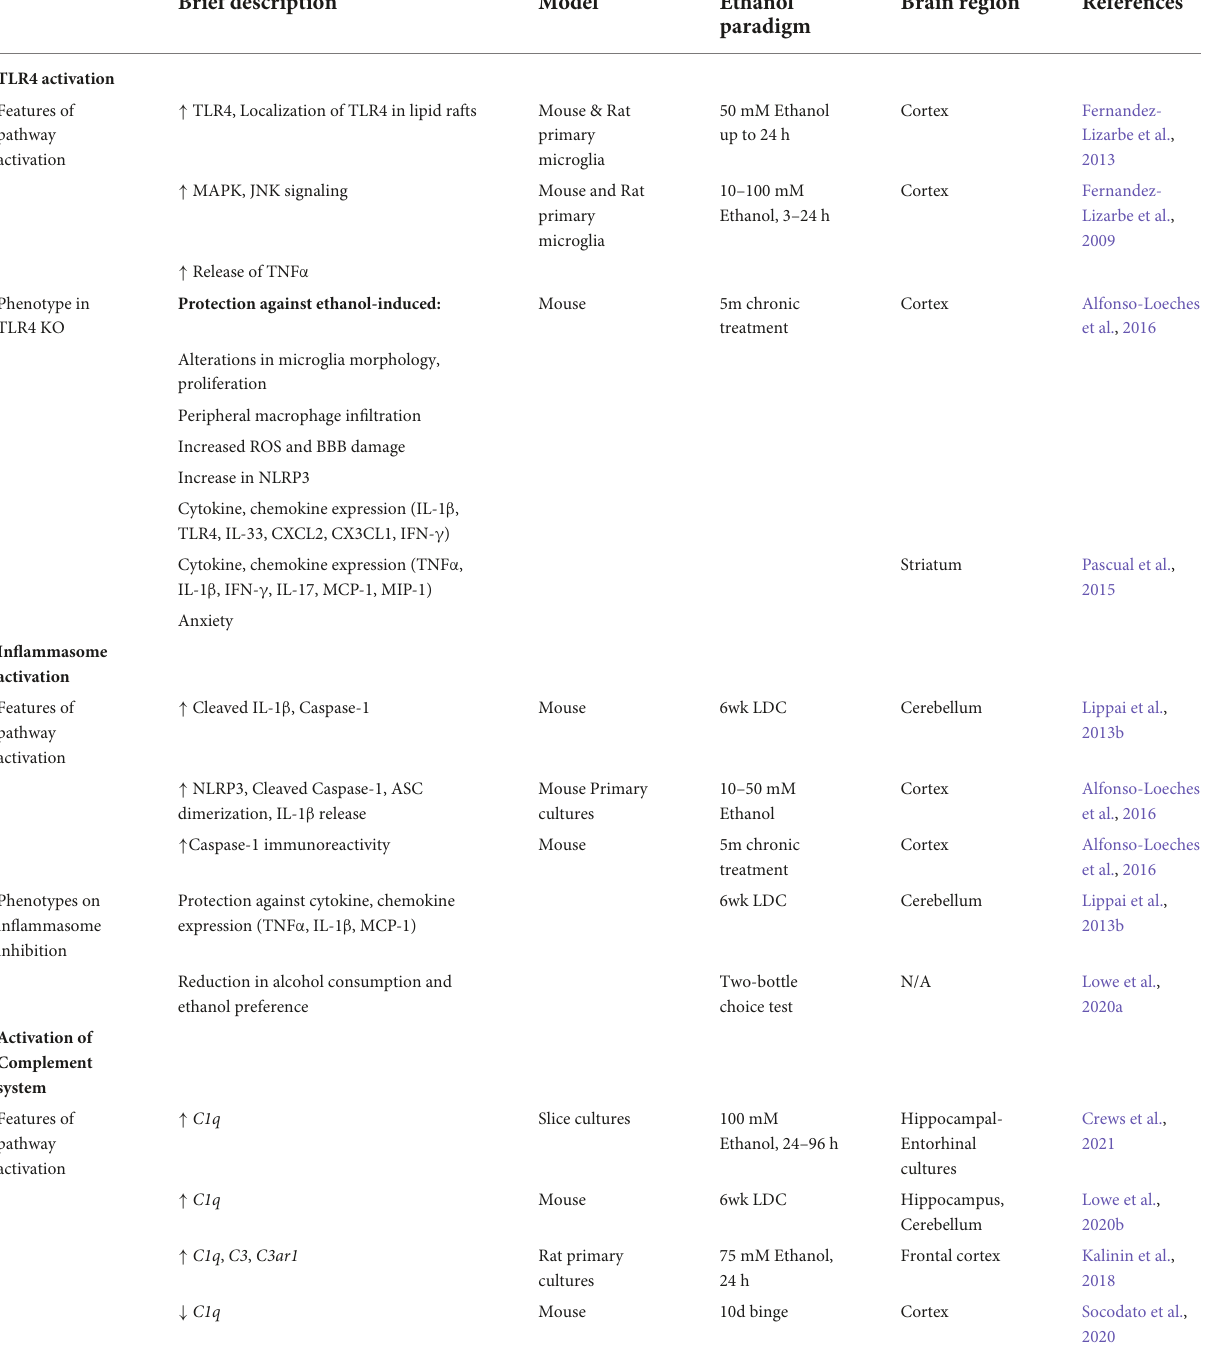
TABLE 2 Mechanisms that lead to ethanol-reactive microglia in alcohol use